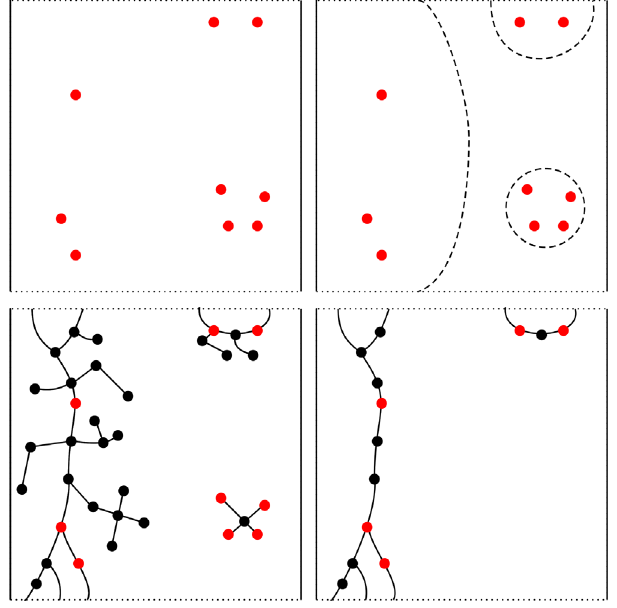
trials.FIG. 2. The square represents the decoder graph (unseen) with north-south open boundary conditions. First, the clusters (dashed enclosures) are grown to an erasure consistent with the (red) marked syndromes. We then find maximum-weight spanning trees, with unmarked syndromes in black. After peeling the leaf nodes, we decode the trees using dynamic